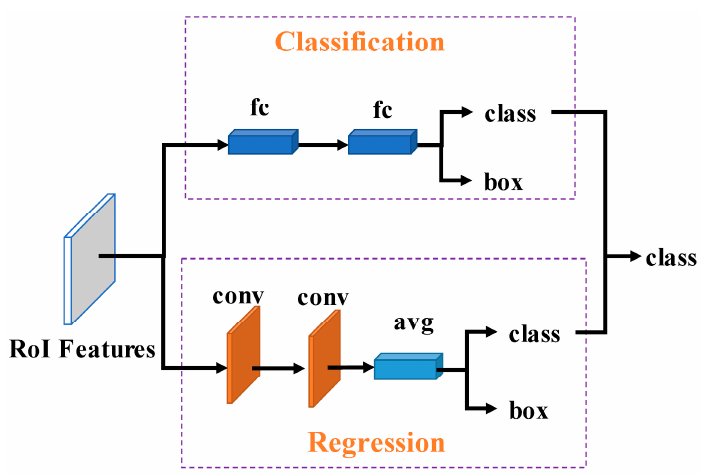
Figure 5. The structure of the double head module. fc: fully connected layer, conv: convolution layer.